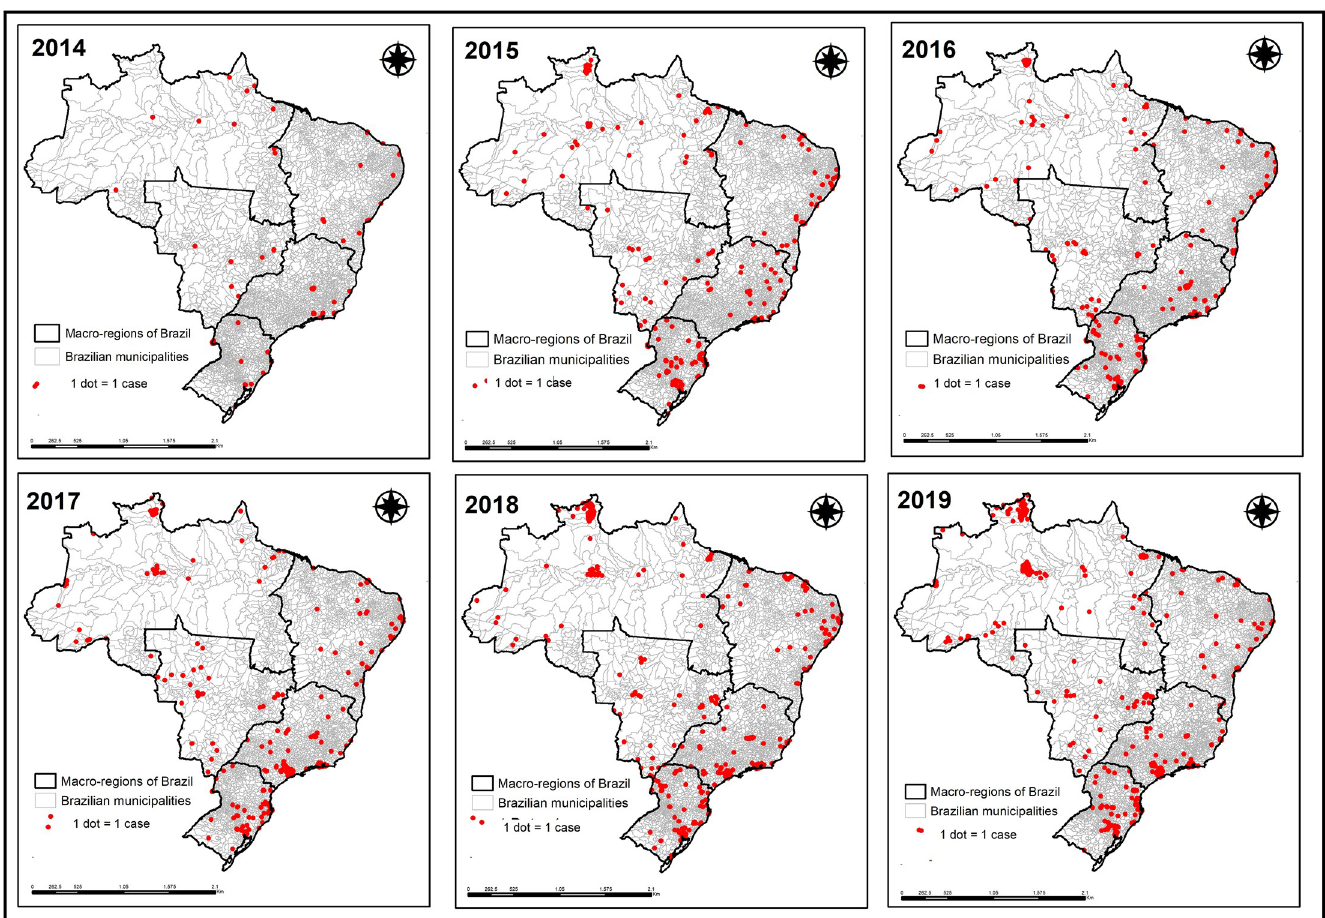
Fig 1. Distribution of tuberculosis cases in migrants according to year of notification, Brazil (2014–2019). Source: prepared by the